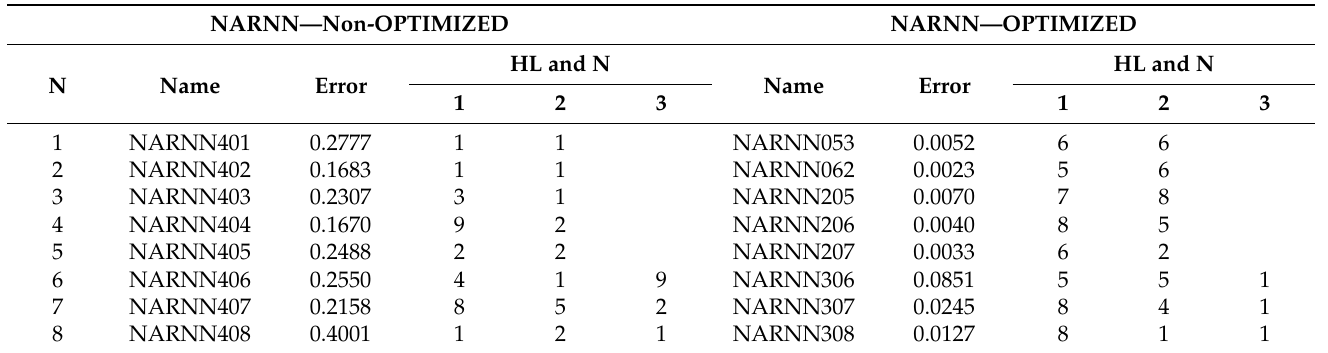
Table 7. Hypothesis test results of the eight non-optimized and optimized NARNNs.